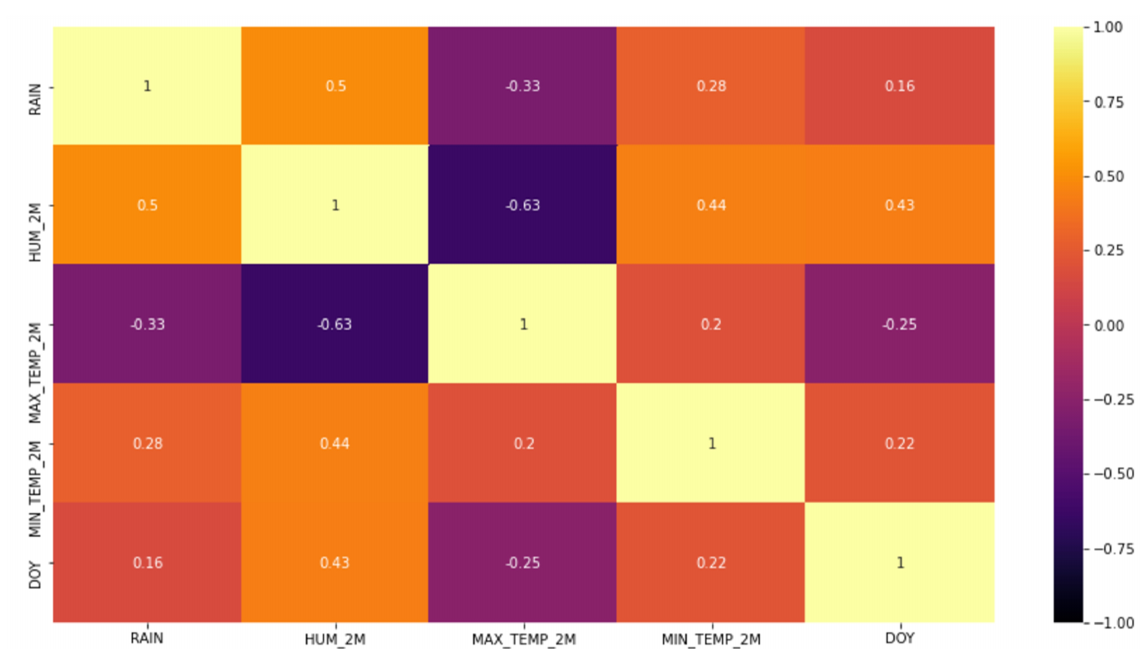
Figure 11. Flowchart summarizing the entire study.